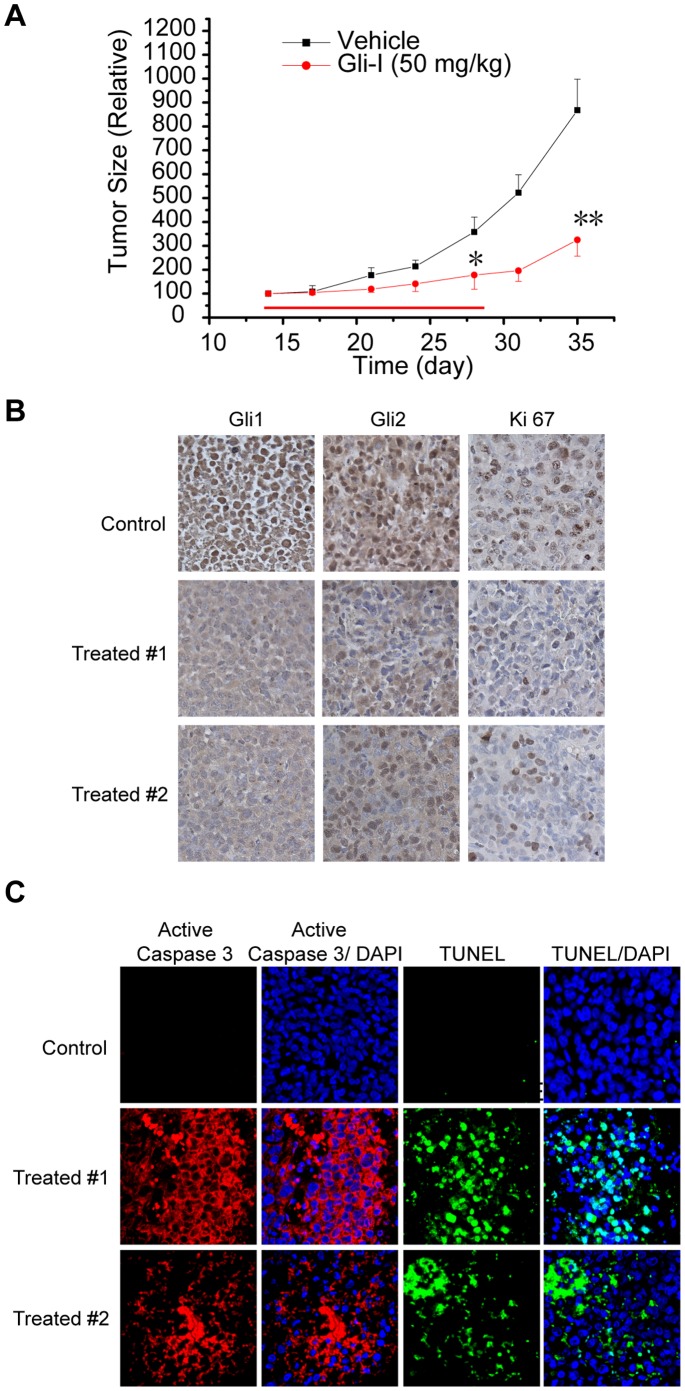
The Gli Inhibitor Suppressed Tumor Growth in vivo by Inhibiting Gli Proteins. A, MS-1 xenograft tumor growth upon Gli-I treatment. Tumor size was measured every 3–4 days. Red arrow indicated the period of drug treatment. Tumor volume was calculated by using the equation x2y/2 (where x<y), and presented as percentage of its initial volume on day 14. Two-sided student’s t-test was performed between control and drug treated mice at day 28 and day 35. A p value <0.05 was indicated as *and <0.01 as **. B, Gli1, Gli2 and Ki67 expression in the resected xenograft tumors by IHC. C, Apoptotic cells in the resected xenograft tumors by IF. Active Caspase 3 (red) with DAPI (blue) in two left columns, and TUNEL (green) with DAPI in two right columns.